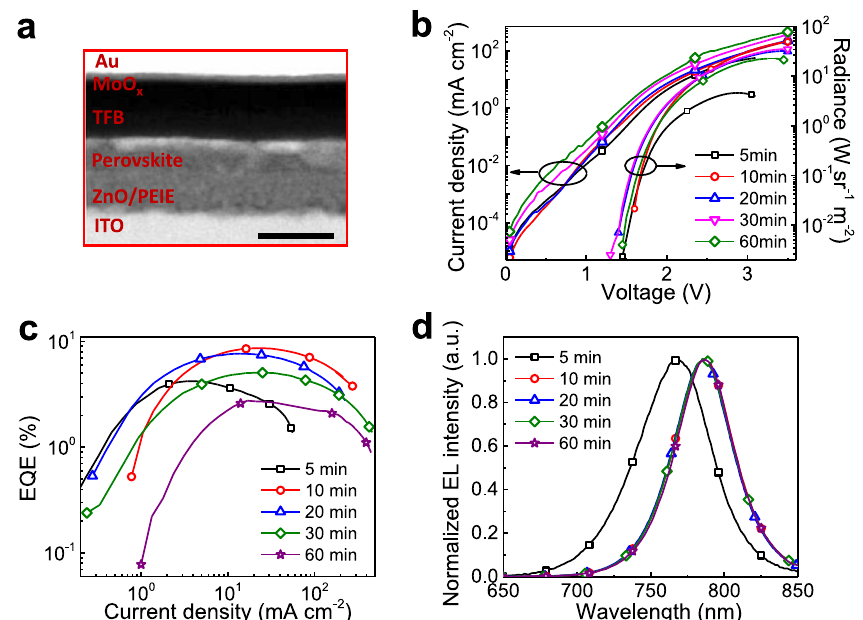
Fig. 4 Device characteristics of the perovskite MQW LEDs. a A cross-sectional HRTEM image for MQW LED with a 10 min annealed perovskite fi lm (scale bar, 50 nm). b Dependence of current density and radiance on the driving voltage. c EQE versus current density. d EL spectra showing the emission peaks red shift as the annealing time